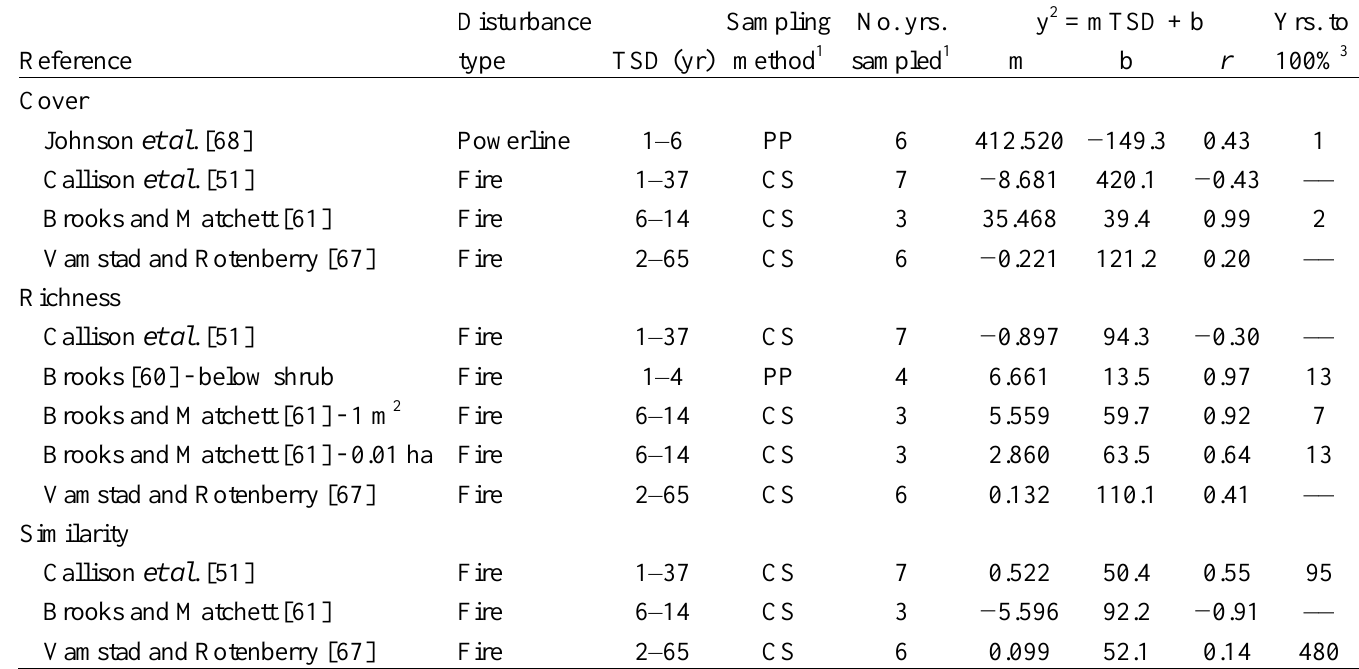
Table 5. Relationship of time since disturbance (TSD) and annual plant community characteristics in the Mojave and Sonoran Deserts of the American